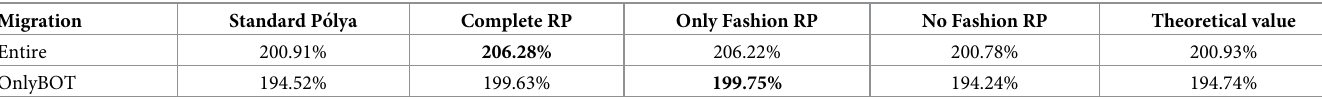
Table 4. “Migration” sample ( T = 0.35, D = 3 0 , S = 100 slots of equal size): Comparison of the different considered models in terms of (6). Migration